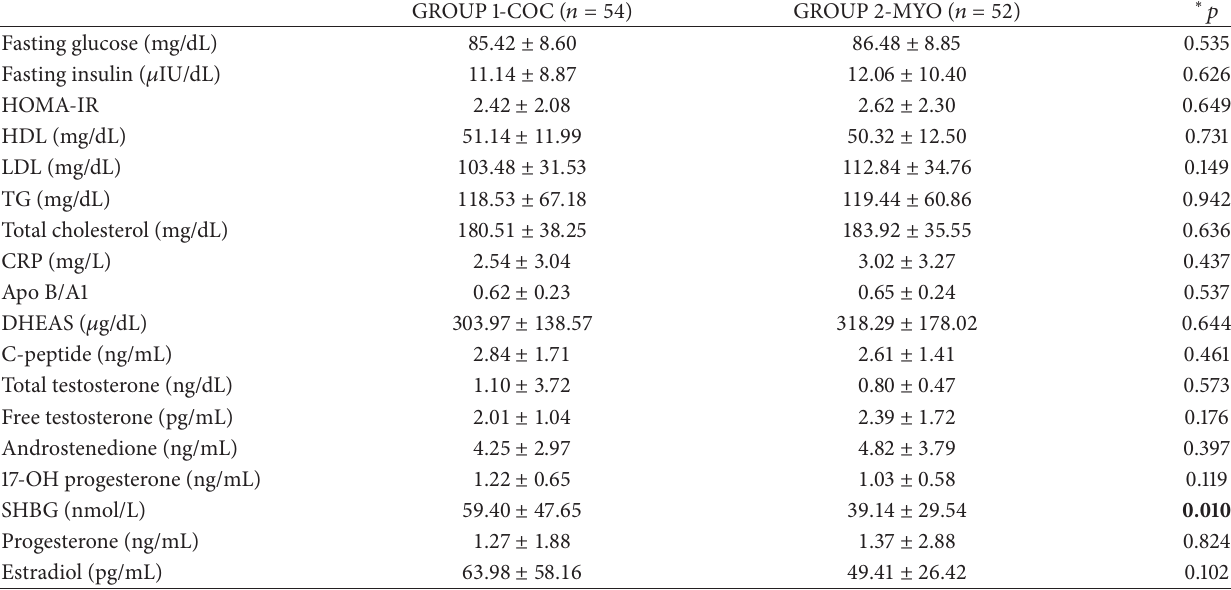
Table 2: Comparison of baseline biochemical and hormonal parameters of patient